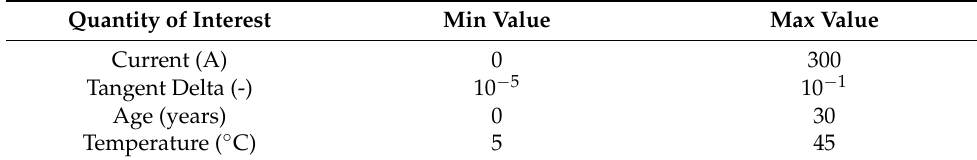
Table 2. Variation ranges of the quantities of